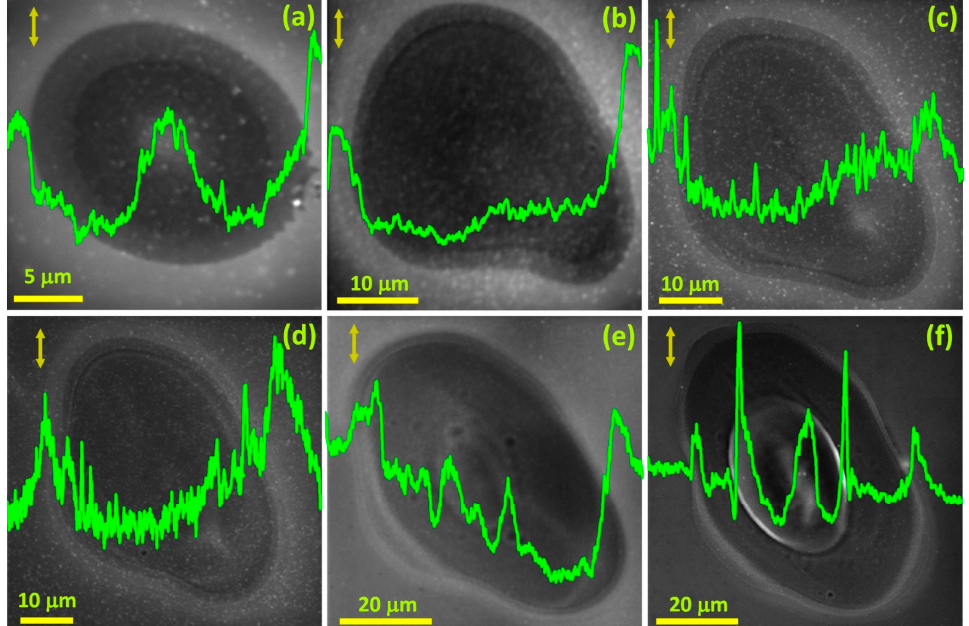
Figure 4. SEM micrographs of spot areas on Si (001) modified with spatially isolated 38 fs linear pulses of fluence ( a ) 0.13 J/cm 2 ( b ) 0.3 J/cm 2 ( c ) 0.5 J/cm 2 ( d ) 0.7 J/cm 2 ( e ) 1.56 J/cm 2 ( f ) 3 J/cm 2 . The plot on each spot is representative of the height profile along a horizontal line (single pixels array) through the center of the modified spot area. As the height profiles are the result of an intensity analysis per pixel, the obtained values do not reflect the actual